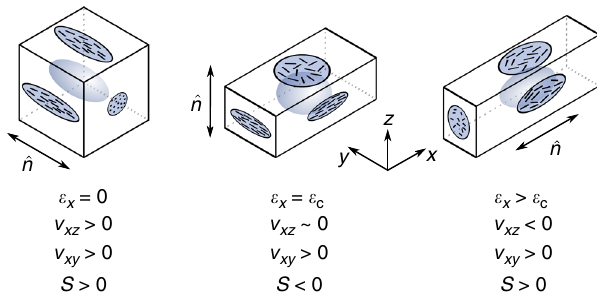
Fig. 6 Relationships between LC order and the strain-dependent Poisson ’ s ratios. Model of the deformation described by: the relationships between the sample geometry (outline box), polymer conformation shape (enclosed ellipsoidal shapes) and LCOP (denoted as S ) projected on each plane (rod arrangements). At the critical strain, ε c , the symmetry of the LC ordering corresponds to a negative order parameter with the director (symbolised by vectors-n) lying parallel to the z-